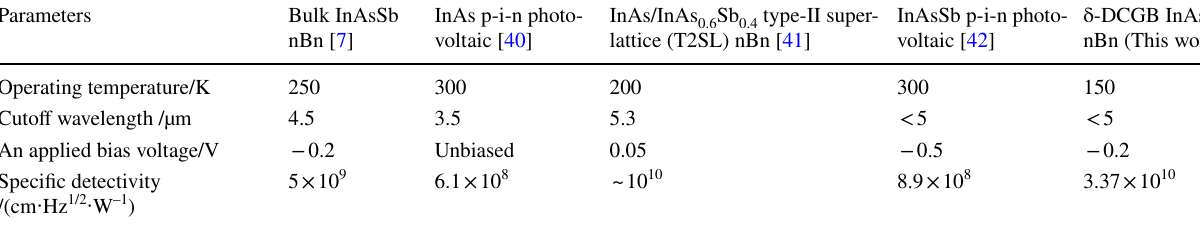
Summary of the performance of recently presented MWIR photodetectors Parameters Bulk InAsSb nBn